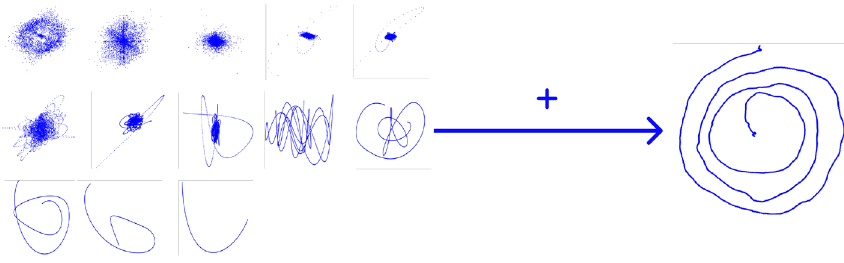
Figure 2. The process of generating a new sample using different IMFs of random subjects of the same class.